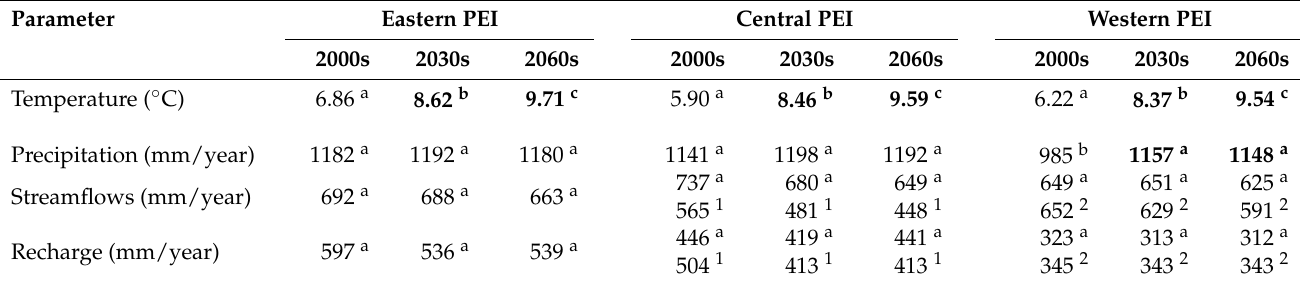
Table 16. Observed and projected (RCP4.5) climatic and hydrological parameters in different zones of Prince Edward